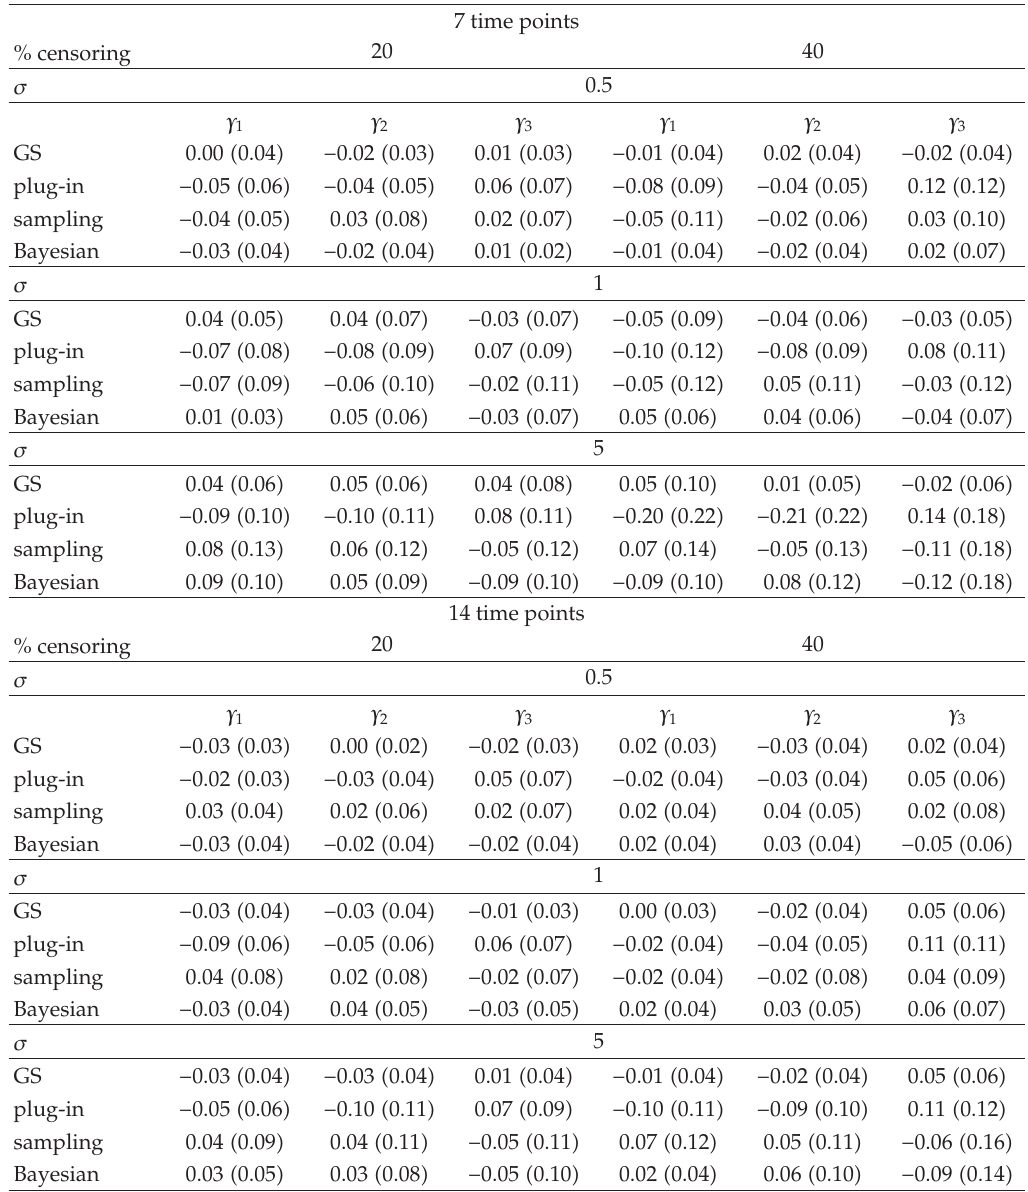
Table 3: Bias and residual mean squared error (cid:6) RMSE (cid:7) for the method with true φ i (cid:6) GS (cid:7) , Empirical Bayes (cid:22) φ estimates i (cid:6) Plug-in (cid:7) , sampled φ i , and fully Bayesian